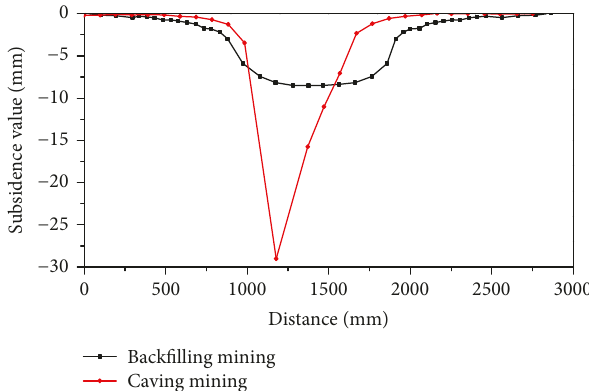
Figure 8: Roof subsidence curve comparison.